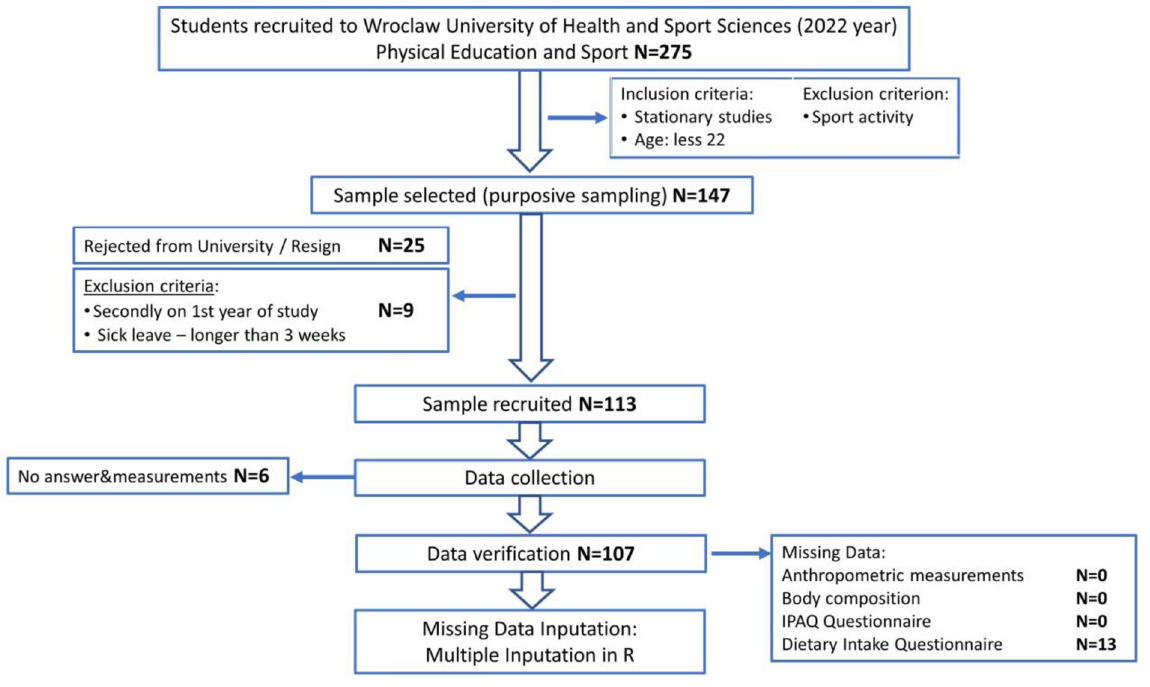
Figure 1. Flowchart of study design and data collection.